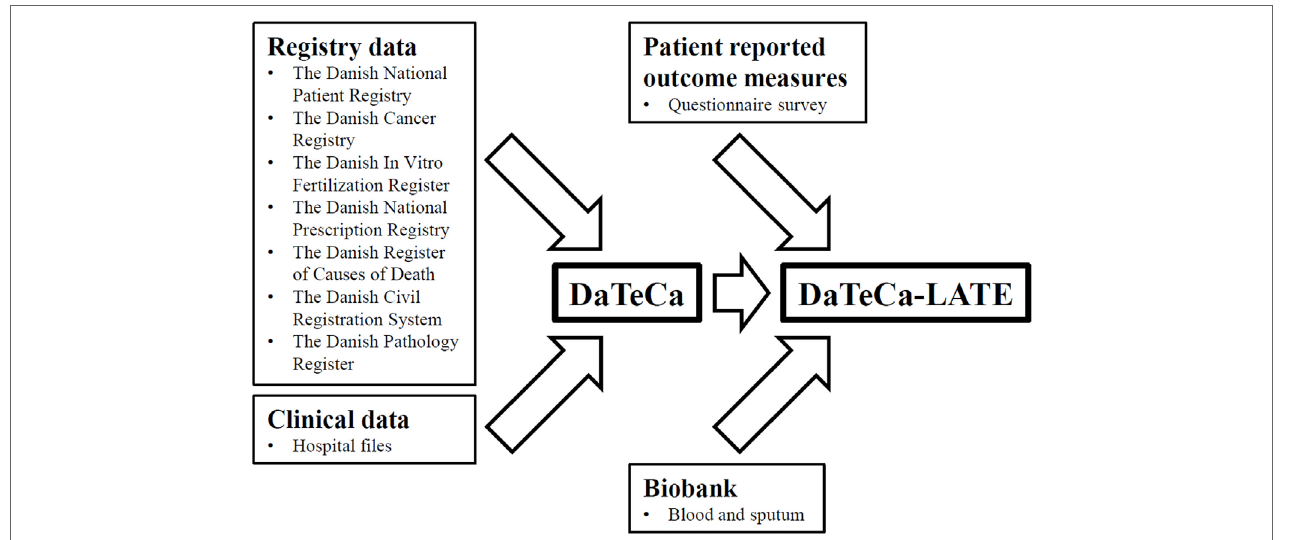
FigUre 1 | The Danish Testicular Cancer Late Treatment Effects Cohort (DaTeCa-LATE) cohort design.